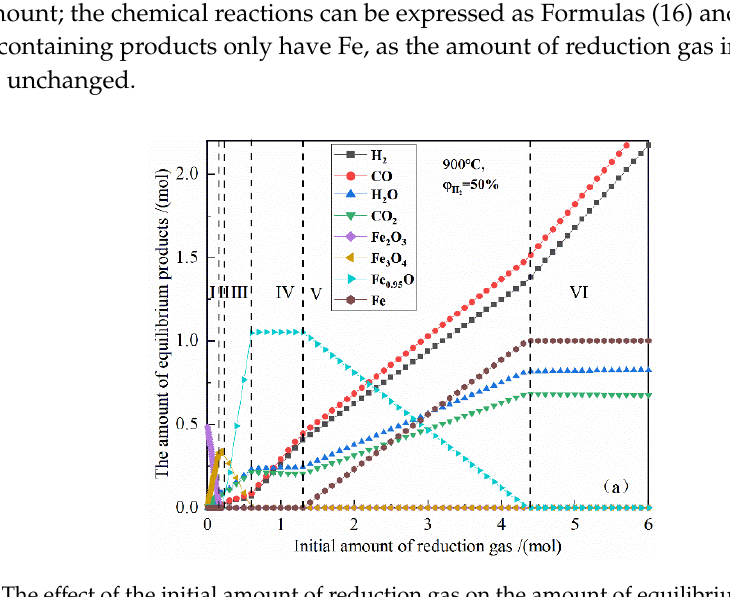
Figure 3. The effect of the initial amount of reduction gas on the amount of equilibrium products in the reduction of 0.5 mol Fe 2 O 3 at 900 ° С .